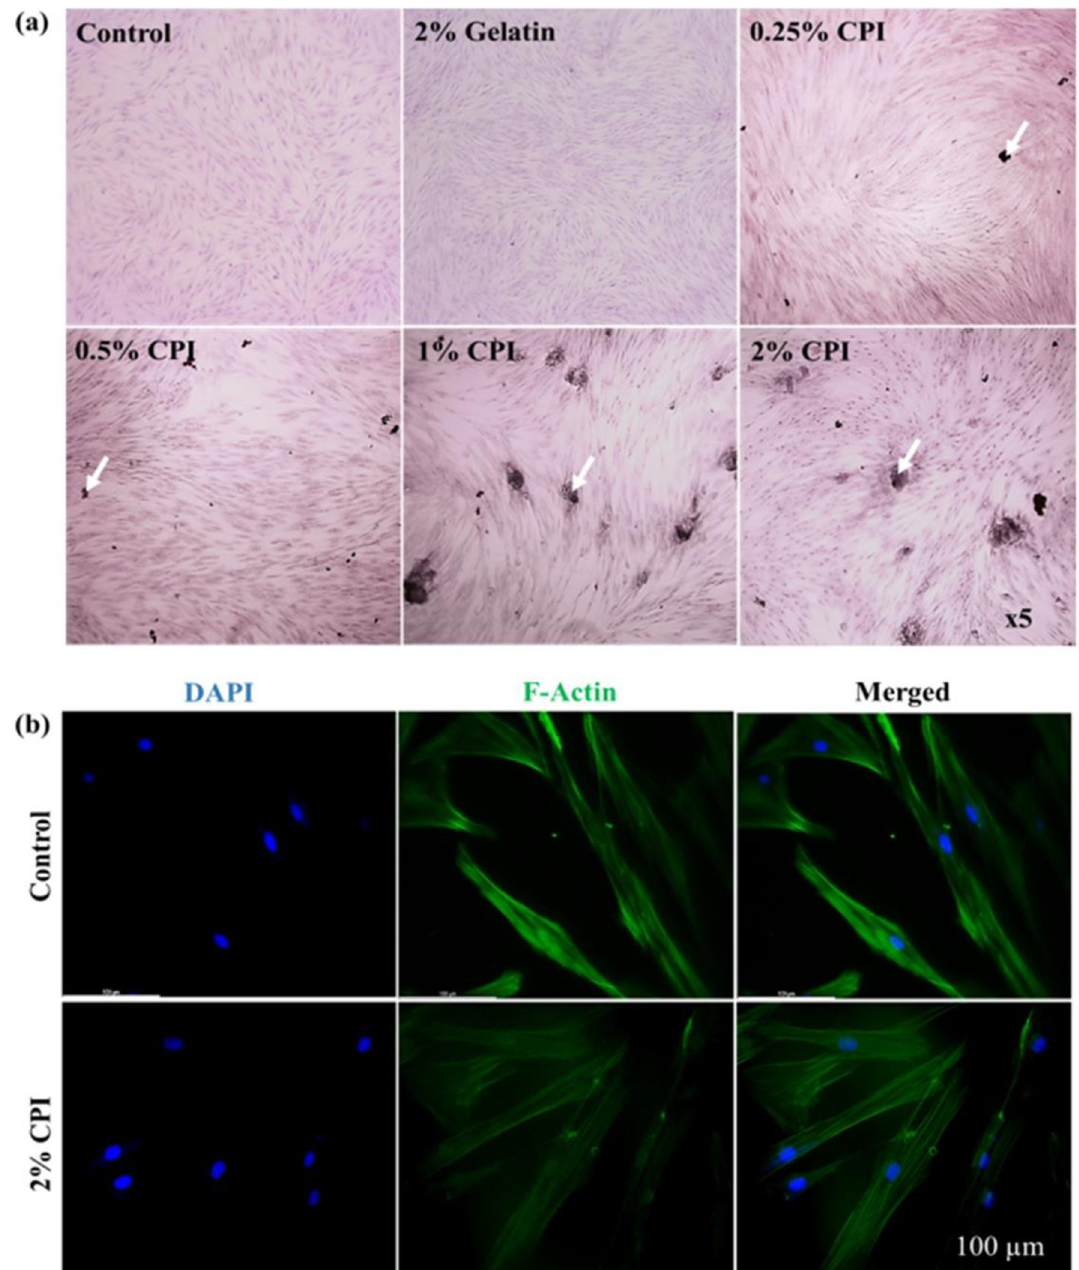
Fig 5. In vitro cytotoxicity evaluation of CPI on hBMSCs after 3 days of incubation. (a) Colony formation efficiency of hBMSCs using Giemsa staining (Mag. × 5) (b) Fluorescence microscopy images of F-actin. The white arrows indicate the presence of stained CPI on the surface of hBMSCs (Scale bar: 100 μ